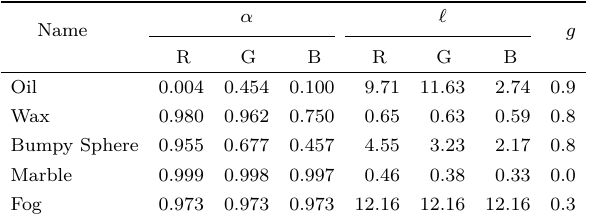
Table 1 Parameters for the materials used in this paper